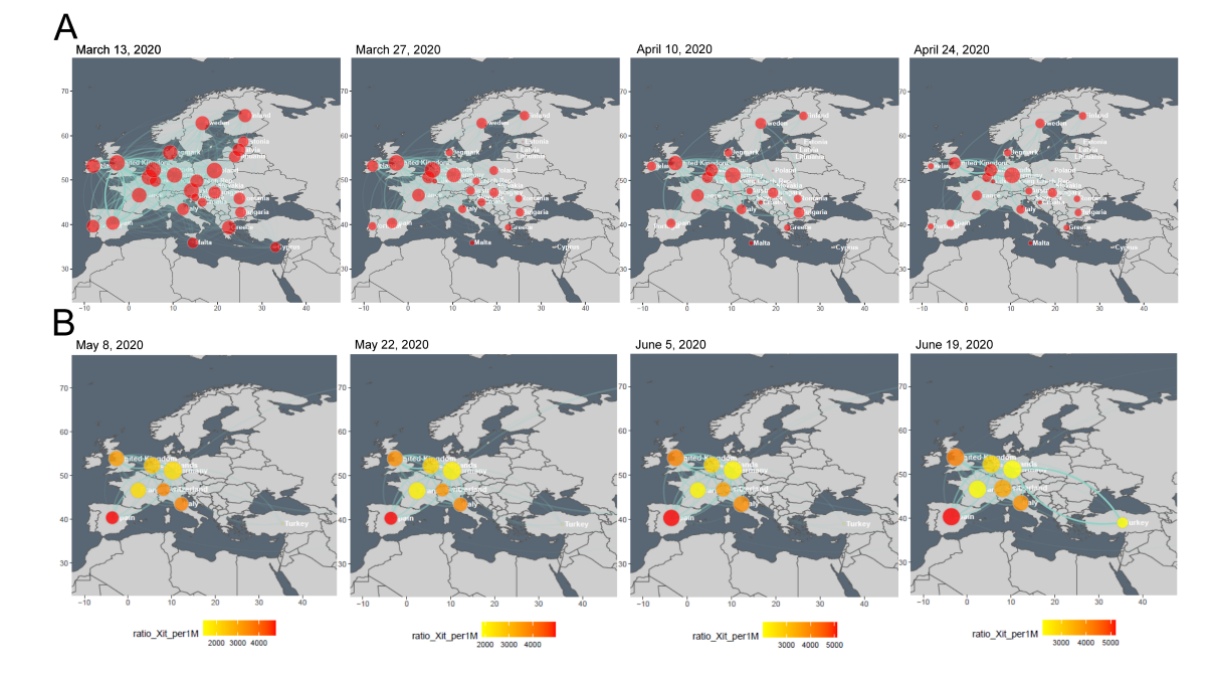
Figure 3. Spatial-temporal maps of connectedness in Europe at (A) the country level between March 13 and April 24, 2020, and (B) air transportation hub level between May 8 and June 19,